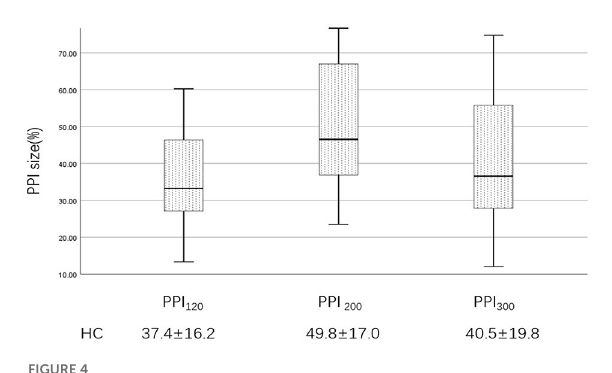
FIGURE4 PPI size of the HC group at ISIs of 120, 200, and 300ms. PPI 120 , prepulse inhibition at ISIs of 120ms; PPI 200 , prepulse inhibition at ISIs of 200ms; PPI 300 , prepulse inhibition at ISIs of 300ms. The comparisons were performed using the one-way analysis of variance.